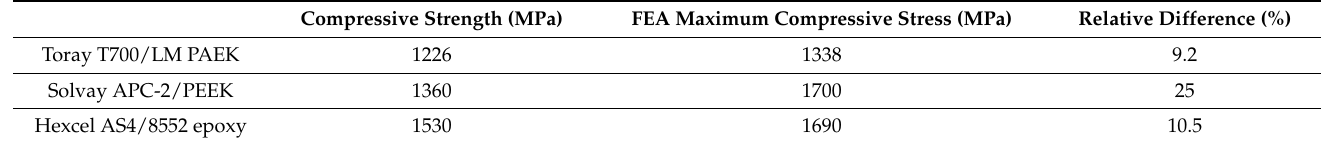
Table 5. FEA compressive stresses and compressive strengths for studied composite systems [3–5].